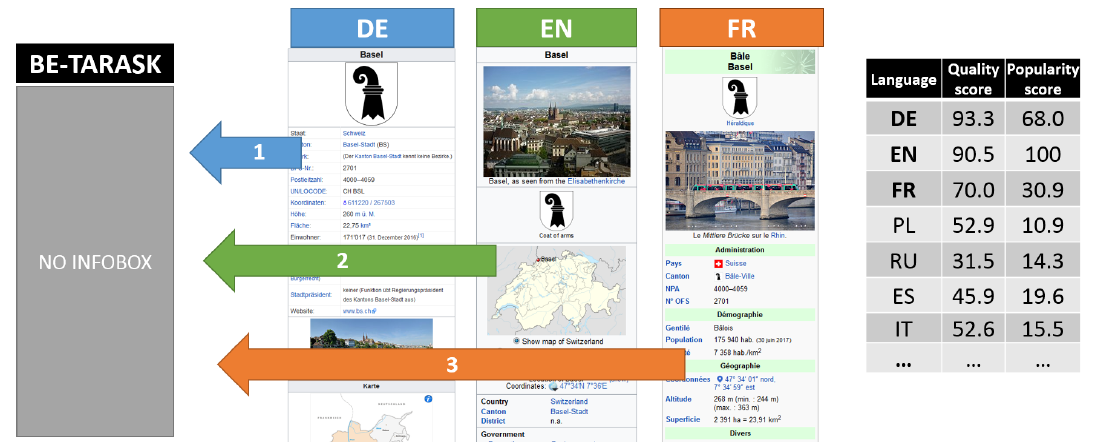
Figure 7. Scheme of information enrichment of Wikipedia infobox on the basis of quality and popularity assessment of other language versions by an example of Basel city. Source: own calculations from September 2017.